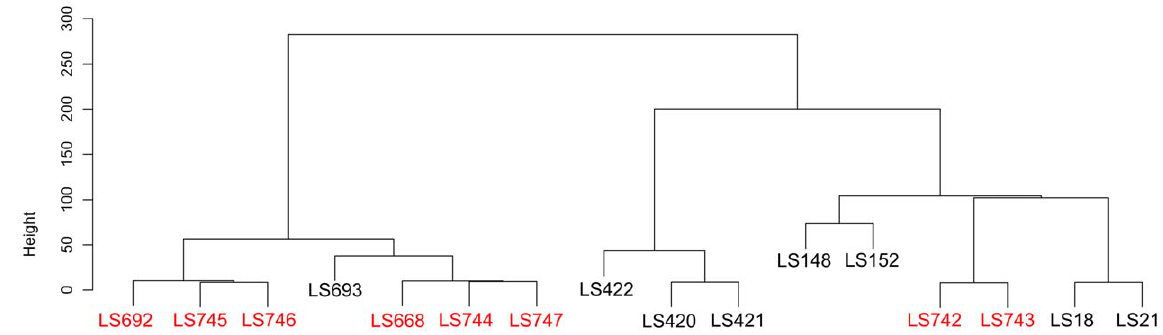
Figure 6. Hierarchical clustering based on the Robust Multi Array (RMA) analysis. Strains highlighted in red indicated the serotype 1/2a strains from the 2011 Cantaloupe outbreak.